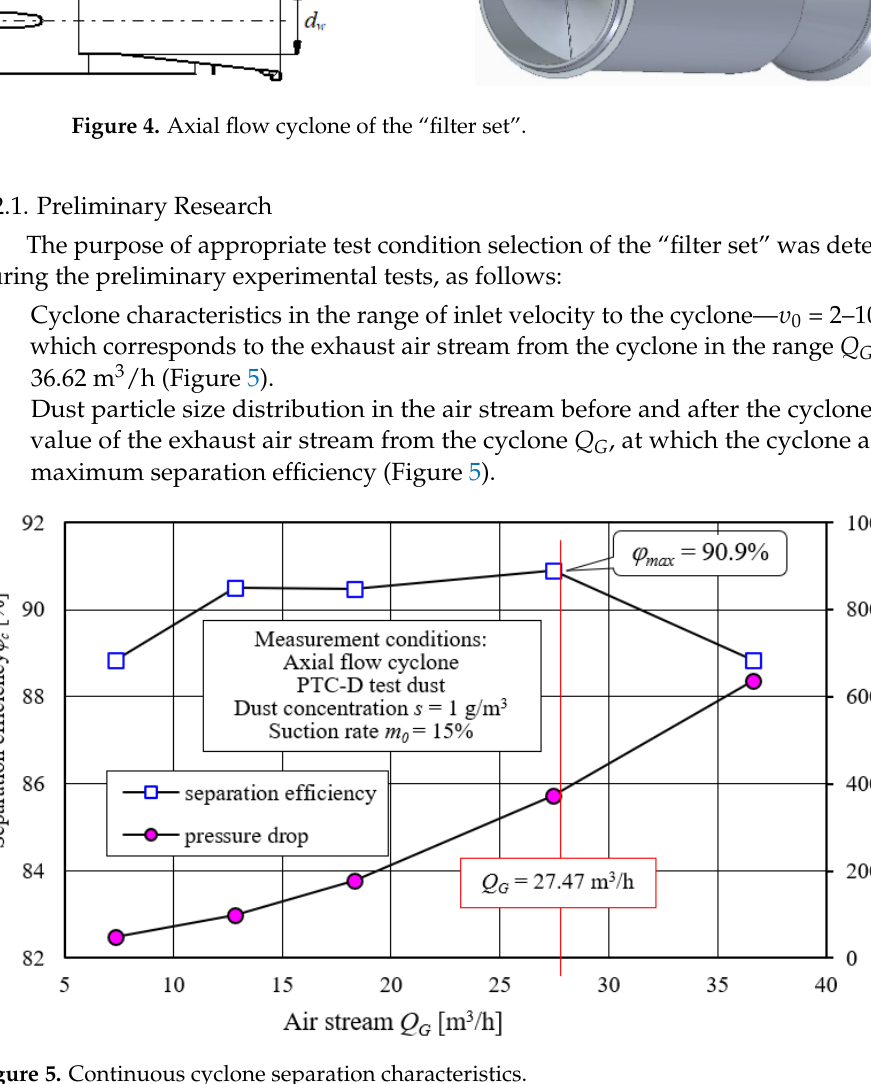
Figure 5. Continuous cyclone separation characteristics.